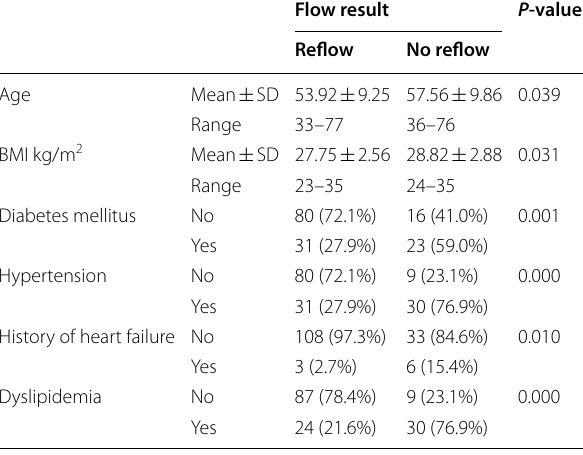
Table 1 Demographics and risk factors of the studied patients